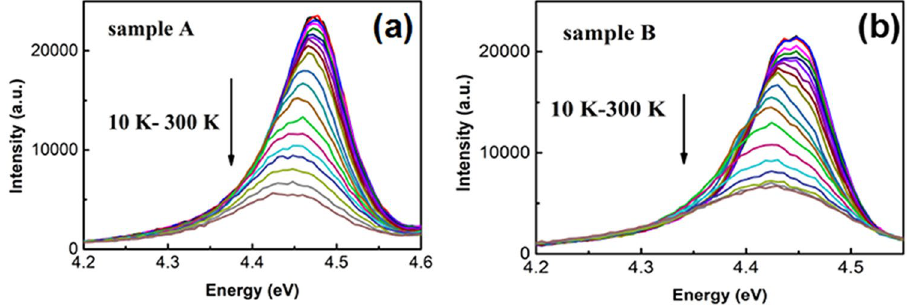
Figure 5. ( a ) Temperature dependent PL spectrum of sample A; ( b ) Temperature dependent PL spectrum of sample B.